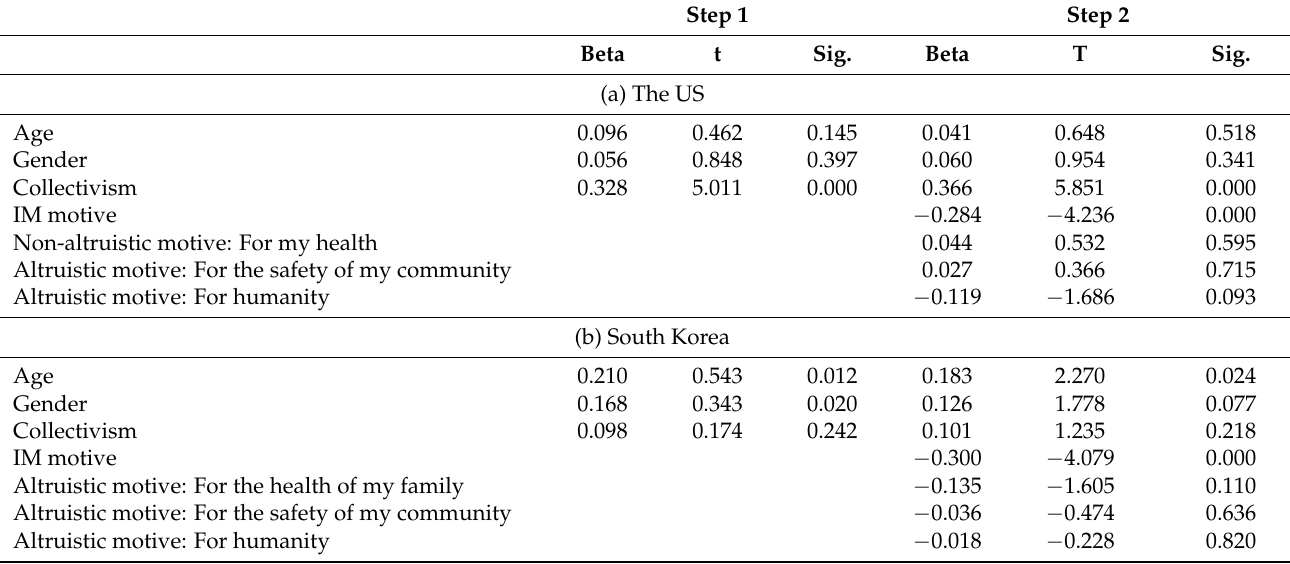
Table 2. Regression analysis summary for each